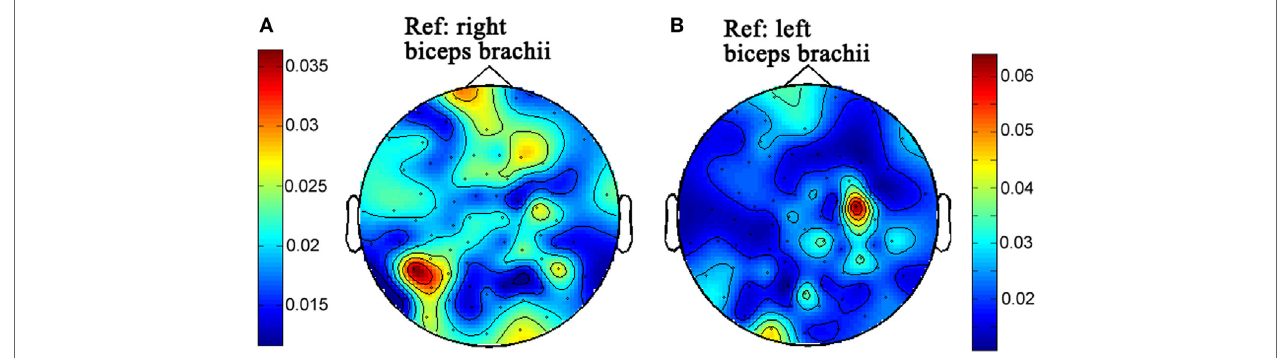
FIgURe 3 | The topographies of beta-band (15–30 Hz) corticomuscular coherence with the peripheral reference of right biceps brachii (a) and left biceps brachii (B) , respectively for the second time of